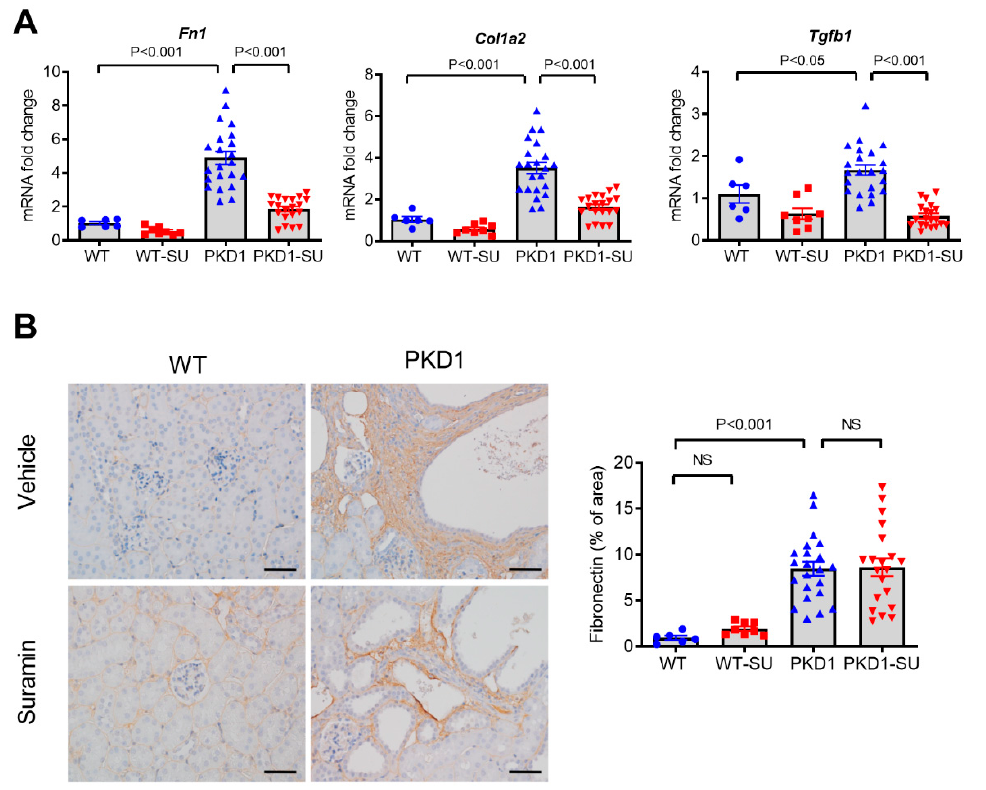
Figure 5. Effect of suramin treatment on renal fibrosis in Pkd1 -miR Tg mice. ( A ) Comparison of the renal Fn1, Col1a2, and Tgfb1 mRNA expression in different study groups as indicated. The internal control gene used for normalization was rodent 18S ribosomal RNA. ( B ) Immunohistochemistry staining for fibronectin in the kidneys of wild-type and Pkd1- miR Tg mice. Quantitative analysis showed increased fibronectin deposition in the cystic kidneys of Pkd1 -miR Tg mice, but no significant changes were noted after treatment with suramin. Scale bar, 50 µm. Data are mean ± SEM. n = 6, 8, 22, and 20 per group, respectively.